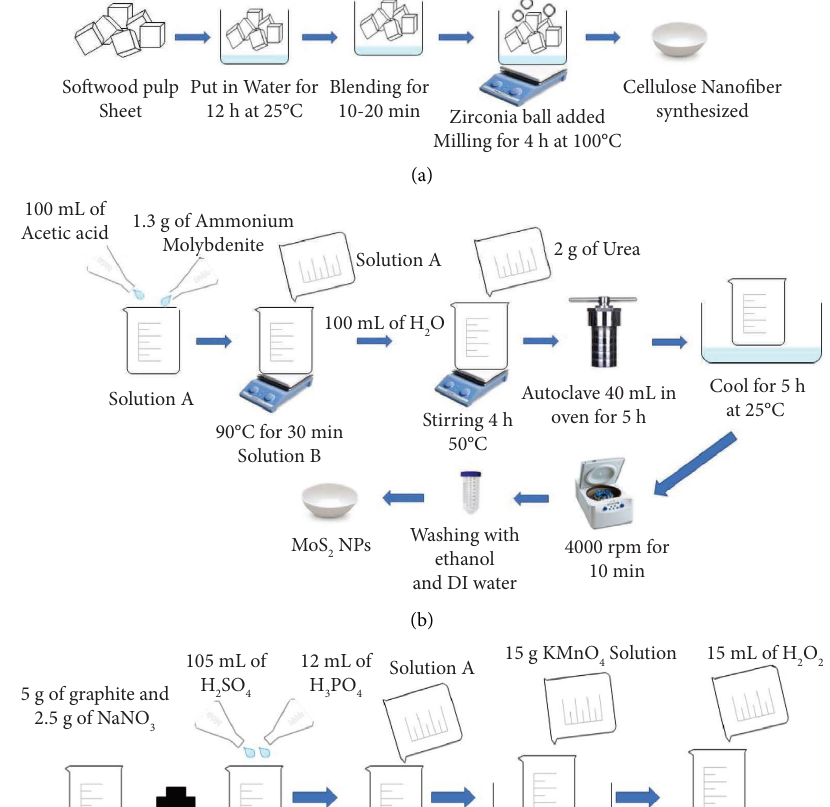
2 NPs. (c) Synthesis of GO nanoparticles. (d) Synthesis of cellulose/MoS 2 /GO